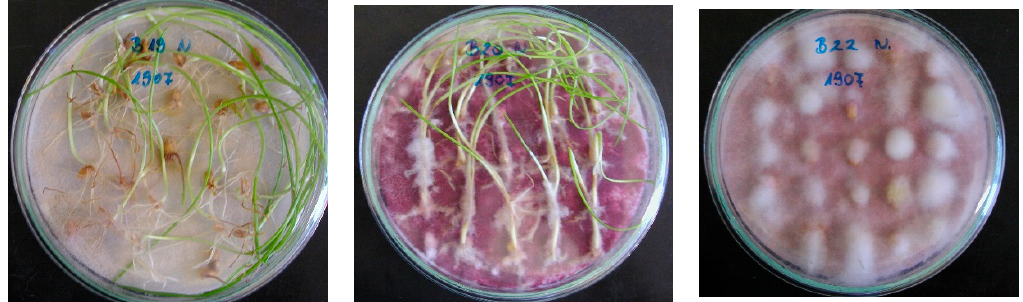
Figure 1. Aggressiveness test with di ff erent isolates of a moderately susceptible genotype No. 1907. Low (B19 left ), medium (B20 middle ) and highly aggressive (B22 right ) isolates of F. graminearum . Original inocula, without dilution or mixing (the pictures are illustrations to show the aggressiveness di ff erences within F. graminearum ).